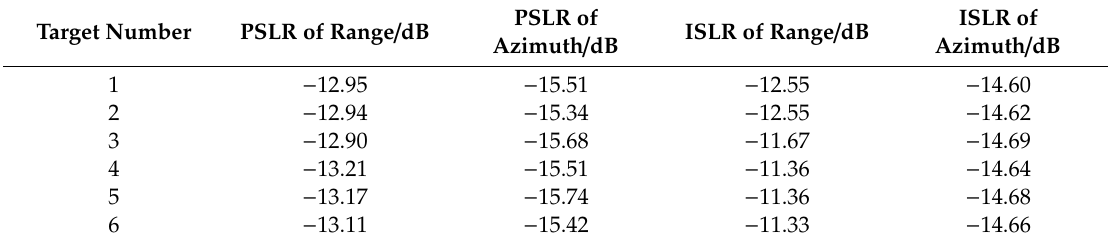
Table 3. Imaging performance of targets. Note: PSLR, peak side lobe ratio; ISLR, integral side lobe ratio.